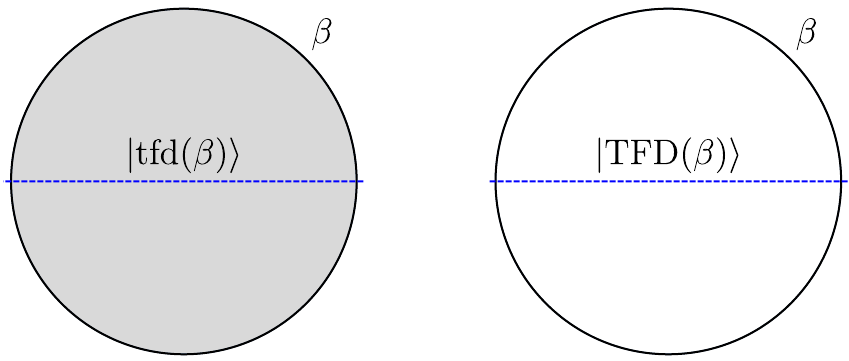
Figure 1 . (Left) The disk contribution to the bulk Euclidean path integral computing the thermal partition function. The boundary has renormalized length β . Cutting the path integral along the dashed blue line gives a state in H grav , the Hilbert space of dilaton gravity on an interval with two asymptotic boundaries. This state is the eternal two-sided black hole in AdS 2 . (Right) The boundary Euclidean path integral computing the thermal partition function. Cutting the path integral along the dashed blue line gives the thermofield double state in two copies H B ⊗ H B of the microscopic Hilbert space. In the asymptotic e − S 0 expansion of JT gravity (2.1), this path integral is computed by summing over all possible Euclidean geometries and topologies which fill in the circle. This includes the disk, the disk with a handle, and so